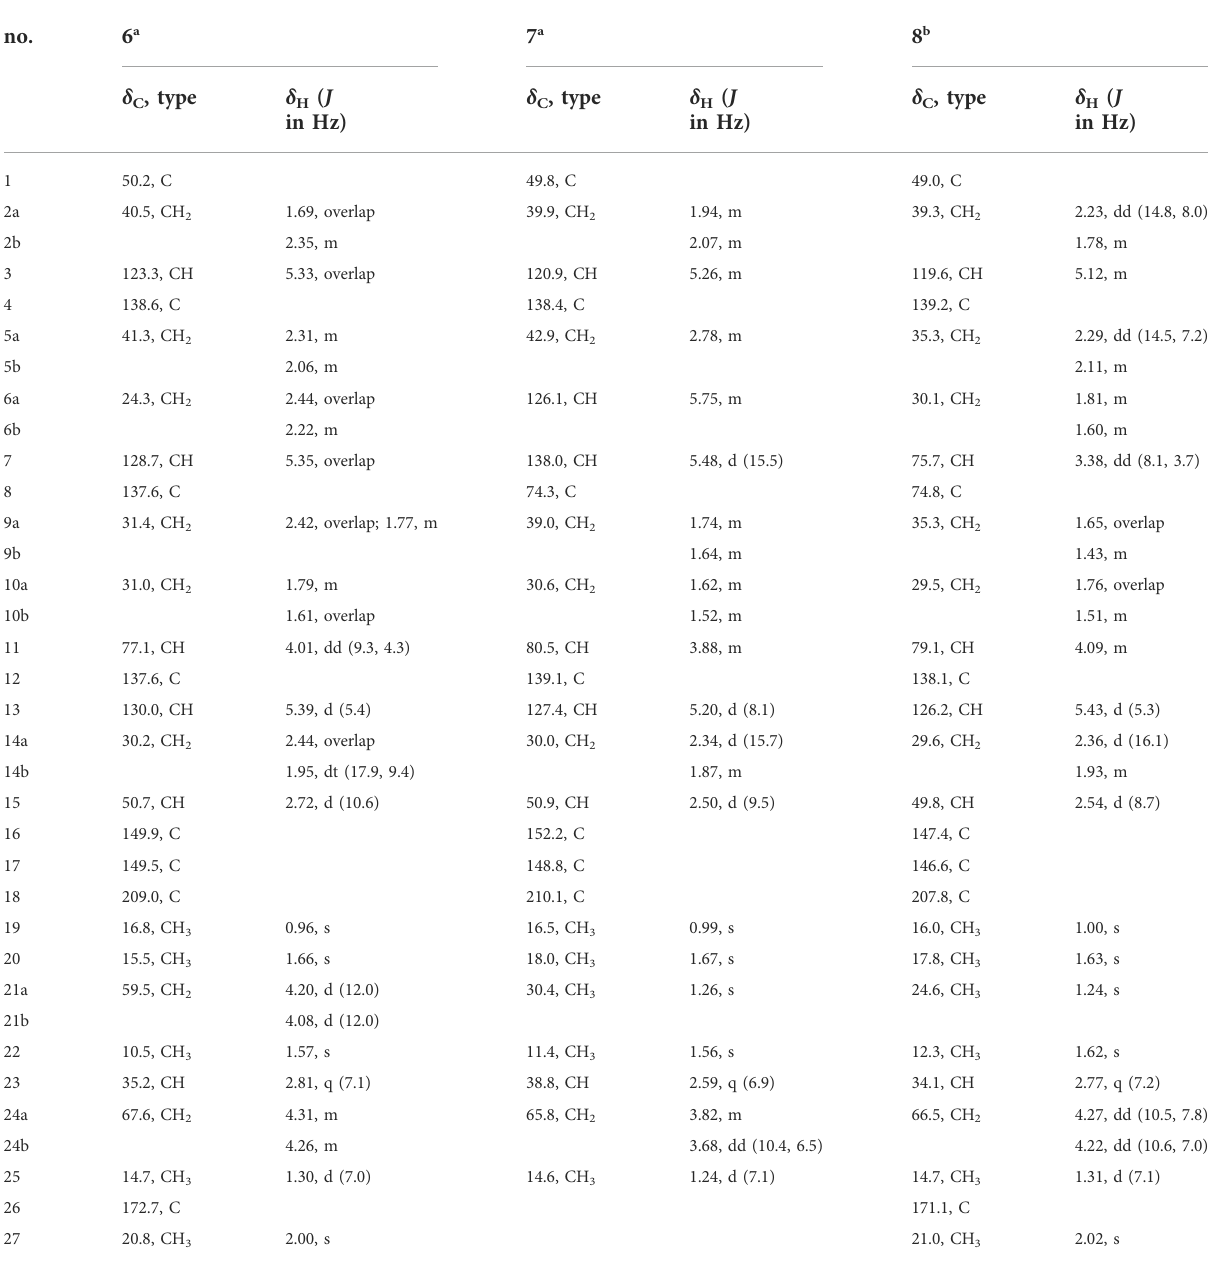
TABLE 3 1 H and 13 C NMR data for 6 – 8 ( δ in